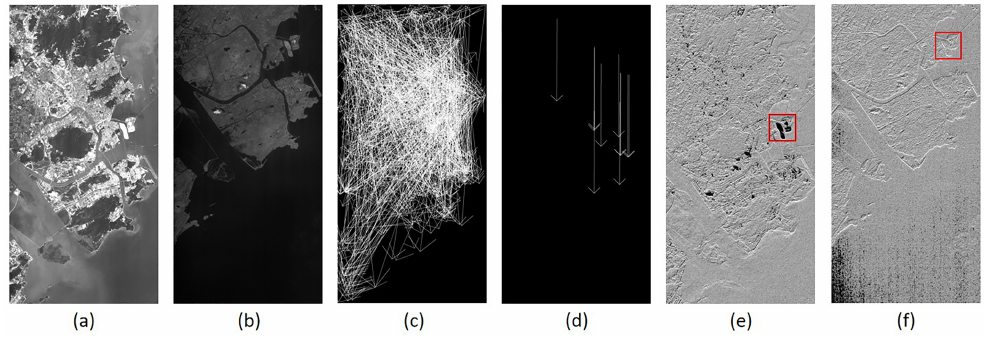
Figure 3. The original image (32nd band) and target image (15th band) of the OHS image and its motion field and gradient direction. ( a , b ) are the 15th band and 32nd band images, respectively; ( c ) is the putative matching motion field from the original image to the target image, that is, the m i set of all feature points from the original image to the target image, and it contains many outliers; ( d ) is the motion field of the inliers, which is detected manually and which is the ground truth of this experiment; ( e , f ) are the gradient patterns of the 15th band and the 32nd band, respectively; the grayscale values represent the gradient direction of the